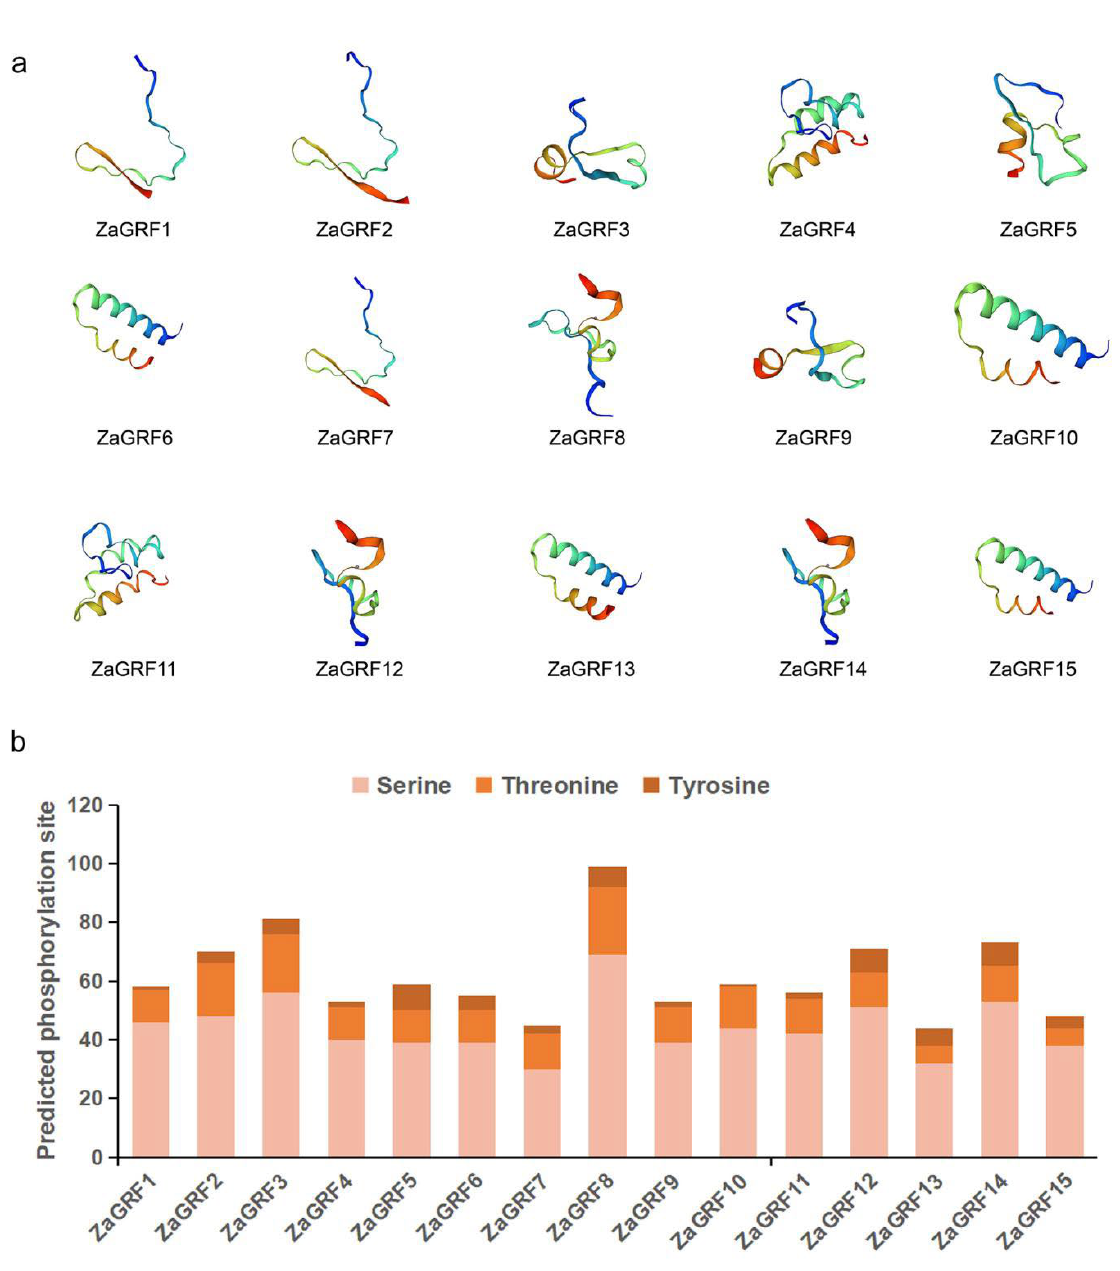
Figure 3. The three-dimensional structures (a) and phosphorylation site (b) of